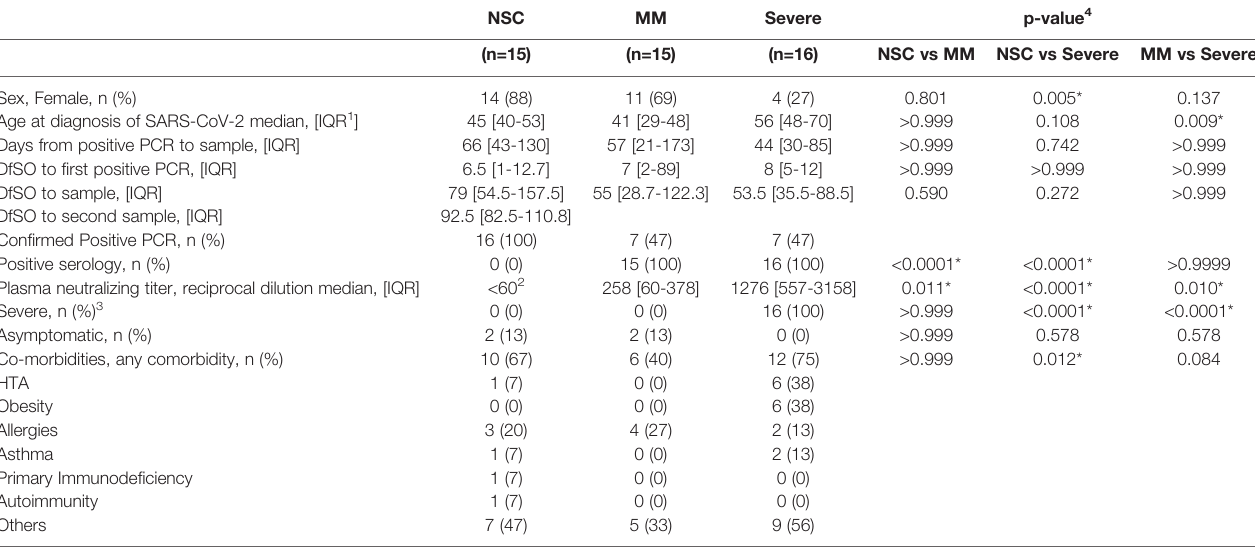
TABLE 1 | Clinical characteristics of the study